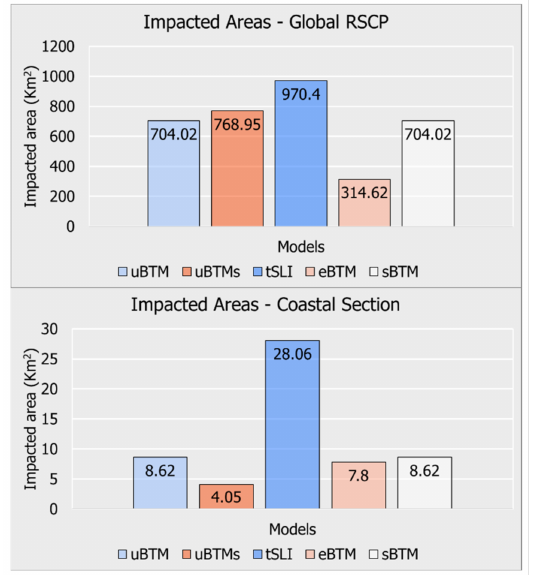
Figure 5. Calculated areas representing the results of the models on Rio Grande do Sul coastal area (RSCP) and coastal section (units in km 2 ).